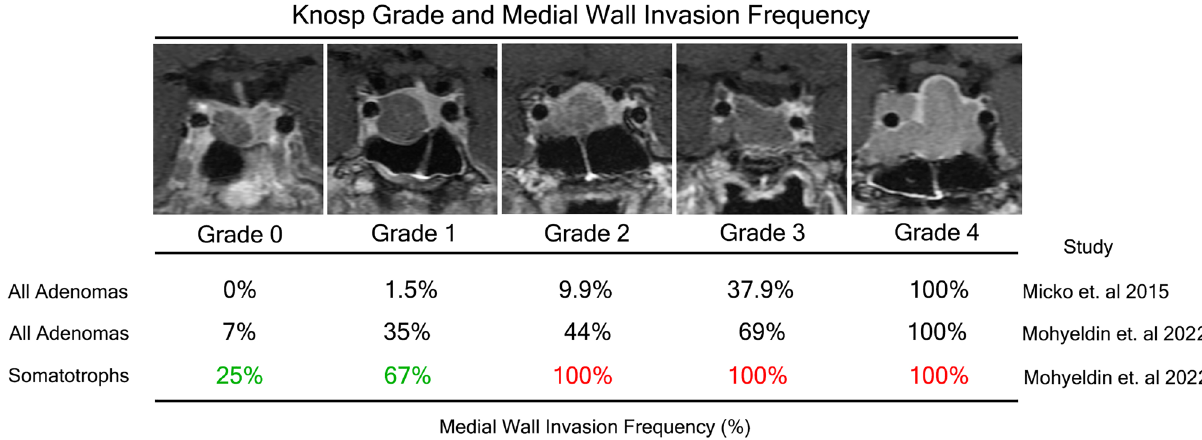
Figure 3. Knosp grade and medial wall invasion frequency as reported by Knosp and colleagues compared to invasion frequencies exhibited in the current study among all adenomas and then among somatotroph adenomas. Representative MRI images from case examples of somatotrophs in our current series stratified by Knosp grade. Knosp criteria were applied based on carotid tangents and each grade is represented by a coronal T1 MRI scan with gadolinium capturing the extent of cavernous sinus